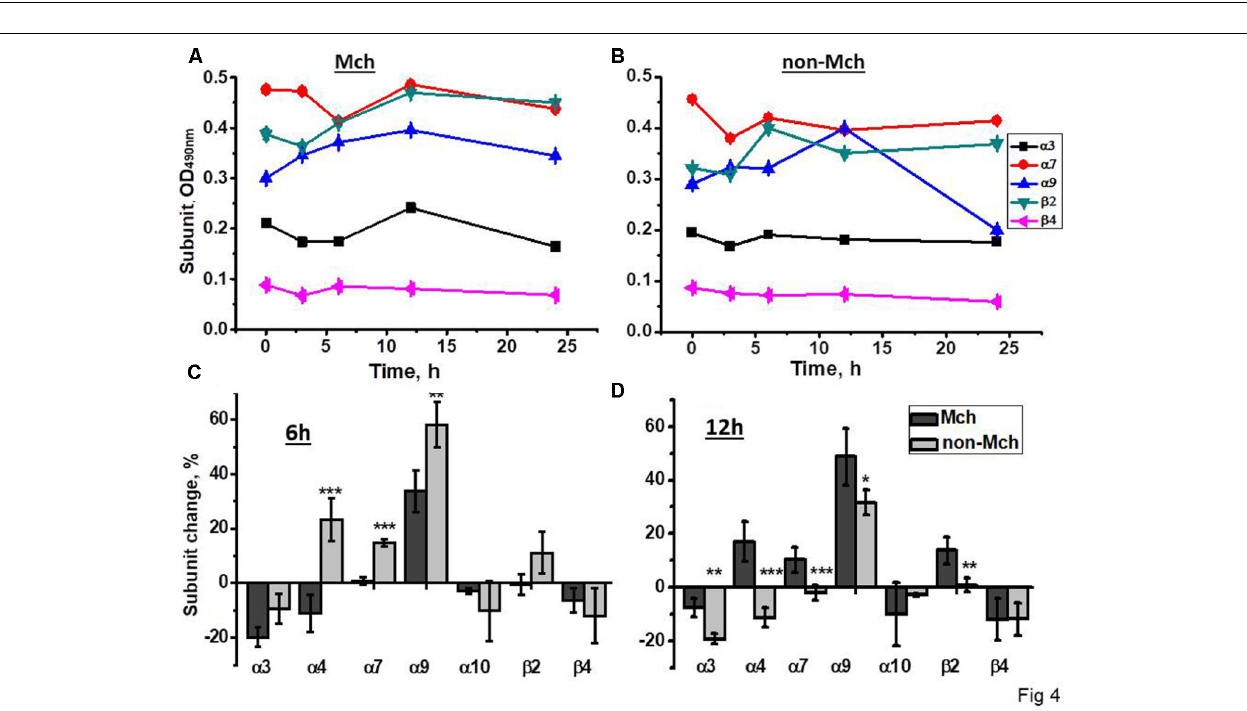
FIGURE 3 | Cyt c released from liver mitochondria of hepatectomized rats under the effect of either Ca 2 + (0.9 µ M) or H 2 O 2 (0.5 mM). (A) Normalized data for one rat per each time point; (B) raw data for three rats per each time point; mean ± SE; ∗ p < 0.05; ∗∗∗ p < 0.0005 compared to pre-operation state (0 h).